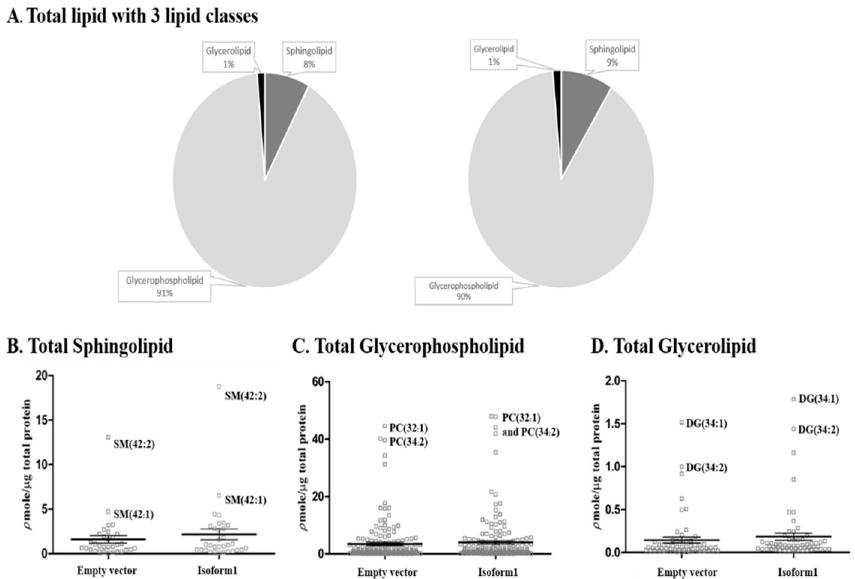
Figure 6. Relative levels of sphingolipids, glycerophospholipids, and glycerolipids in COS-7 cells transfected with empty vector and vector for human GBA2 isoform 1 for 48 h. ( A ) Relative amounts of three classes of lipid species. Levels of specific sphingolipid ( B ), glycerophospholipid ( C ), and glycerolipid ( D ) species and average values in control and cells expressing GBA2 isoform 1 are illustrated as parallel dot plots. Amounts were determined by mass spectrometry analysis of COS-7 cell lipid extracts. Results are representative of three independent replicates .